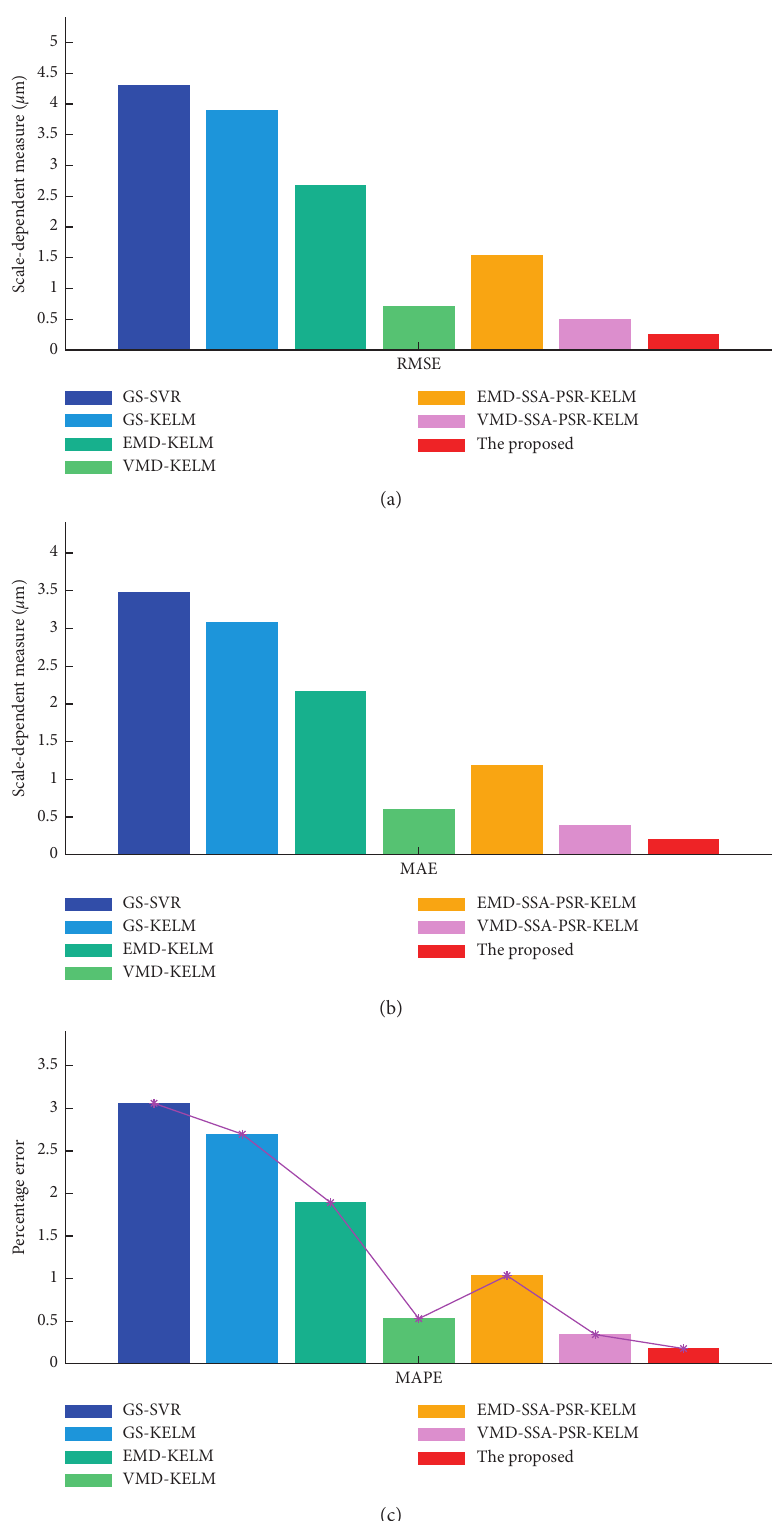
Figure 11: Comparison of all the experimental models in terms of (a) RMSE, (b) MAE, and (c) respectively. Hence, the necessity and the superiority which are much lower than the metrics obtained by of the proposed AMGWO can be demonstrated VMD-SSA-PSR-KELM. Besides, the reduction ratio positively. Furthermore, it can be observed from the of all the metrics is 50.28%, 47.75%, and 47.80%,